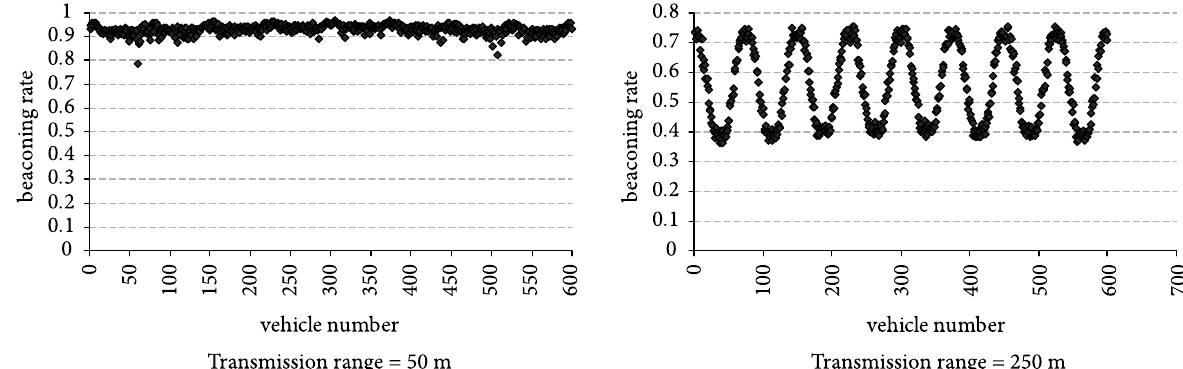
Fig. 5. Beaconing rate of vehicles in different transmission ranges (the 5P200B scenario)